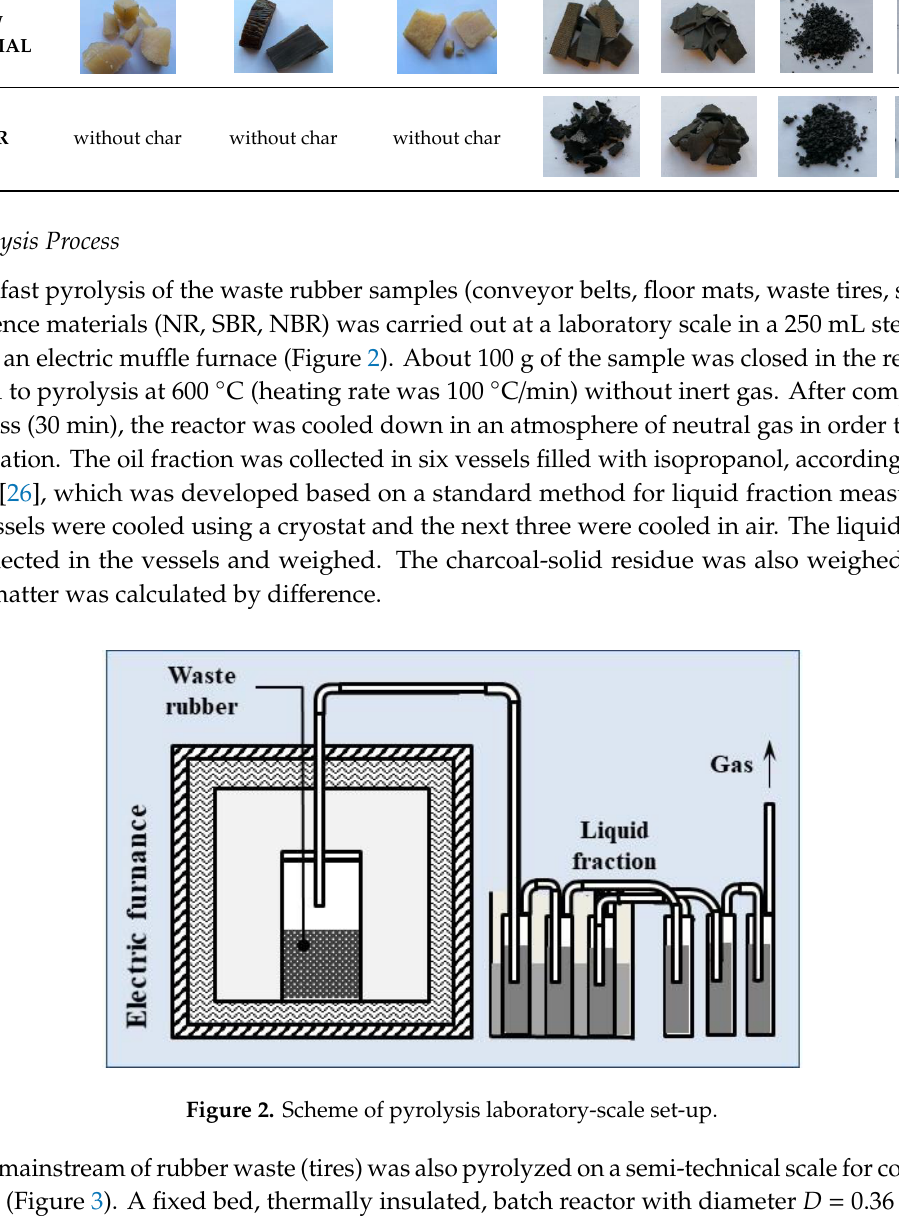
Figure 2. Scheme of pyrolysis laboratory-scale set-up.